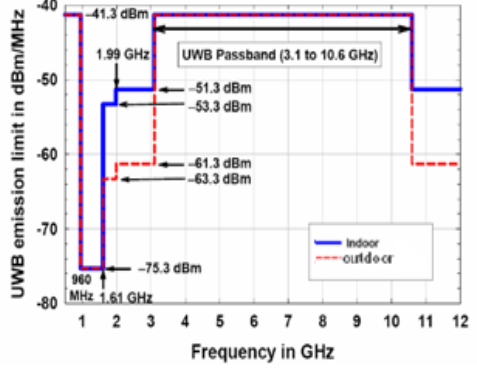
Fig.2. EIRP limits of